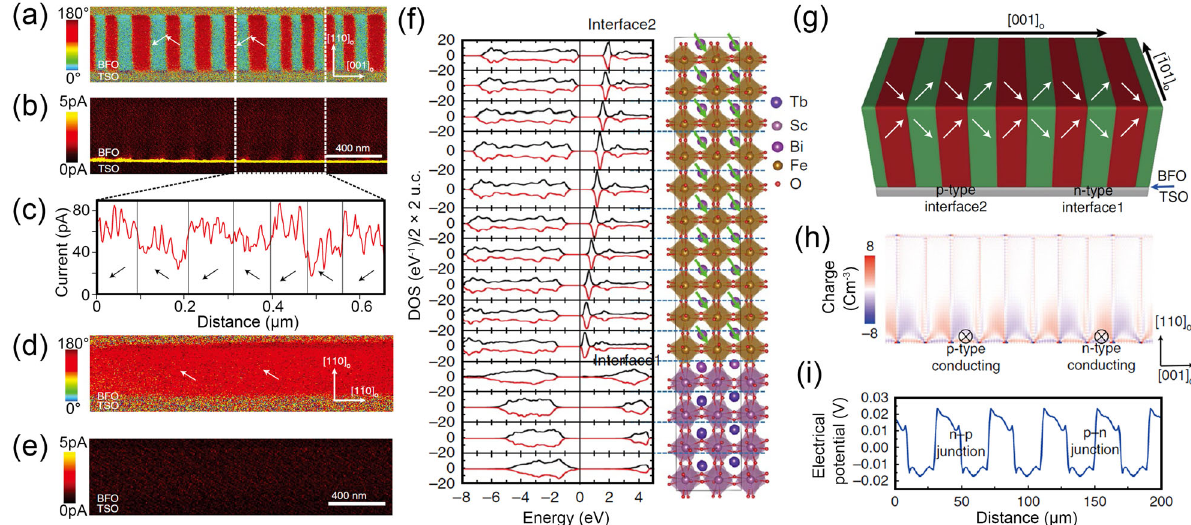
Fig. 4 Anisotropic conductance of 2DEG at the interface of BFO/TSO with 109° domain arrays. a PFM image of BFO in a cross-section specimen perpendicular to the stripe domain. The directions of polarization are indicated by the white arrows. b CAFM image of the same region in ( a ). c Averaged current signal pro fi le along the interface region marked by the white dashed line of ( a ). d PFM image of BFO in a cross-section sample parallel to the stripe domain. e CAFM image of the same region in ( d ), the interface is an insulator in this direction. f Layer-resolved density of state (DOS) and corresponding atomic structure for BFO/TSO (001) interface by fi rst-principles calculations. g Three- dimensional schematic model of BFO domain structure with 109° DWs. h The distribution of bound charge at the BFO/TSO interface along with the domain stripes. The conduction of p-type and n-type are corresponding to interface 2 and interface 1, respectively. i The distribution of electrical potential at the BFO/TSO interface perpendicular to the domain stripes. Reproduced with permission from ref. 48 . Copyright [2018] {Springer